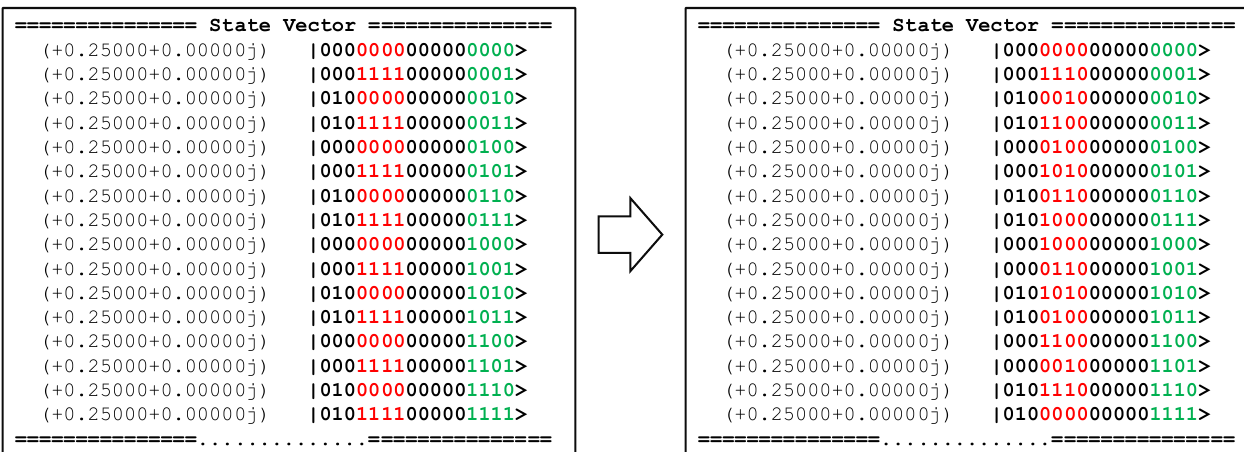
Figure 9. QPULBA 1-2-1 showing the FSM description/program number ( green ) and output tape ( red ): on left the universal distribution and on right the Hamming distance between tape and FSM.